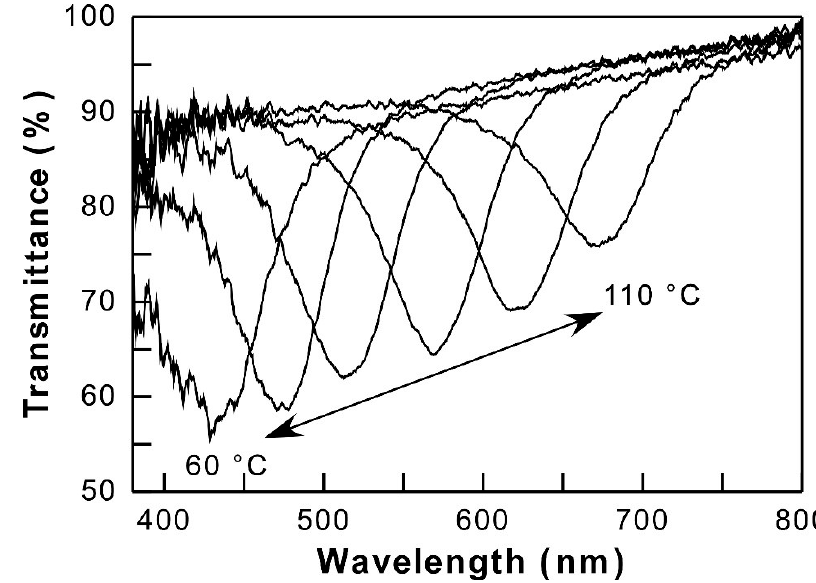
Figure 2. Changes in the transmission spectrum of an HPC derivative with both propionyl esters and p -(trifluoromethyl)phenyl carbamates (HPC-PrE / p -TFMPC; PrE : p-TFMPC = 2.59:0.32) as a function of temperature.